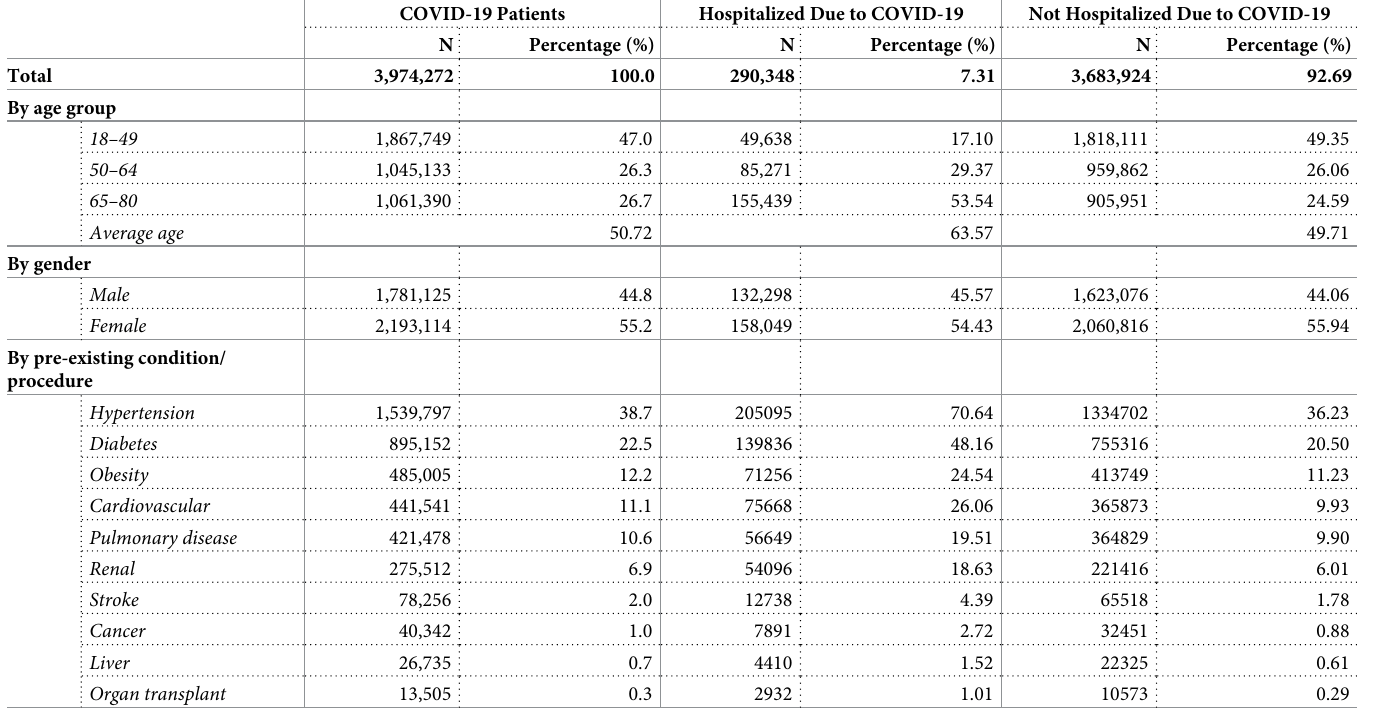
Table 2. Baseline demographics overall, hospitalized due to COVID-19, and not hospitalized due to COVID-19.